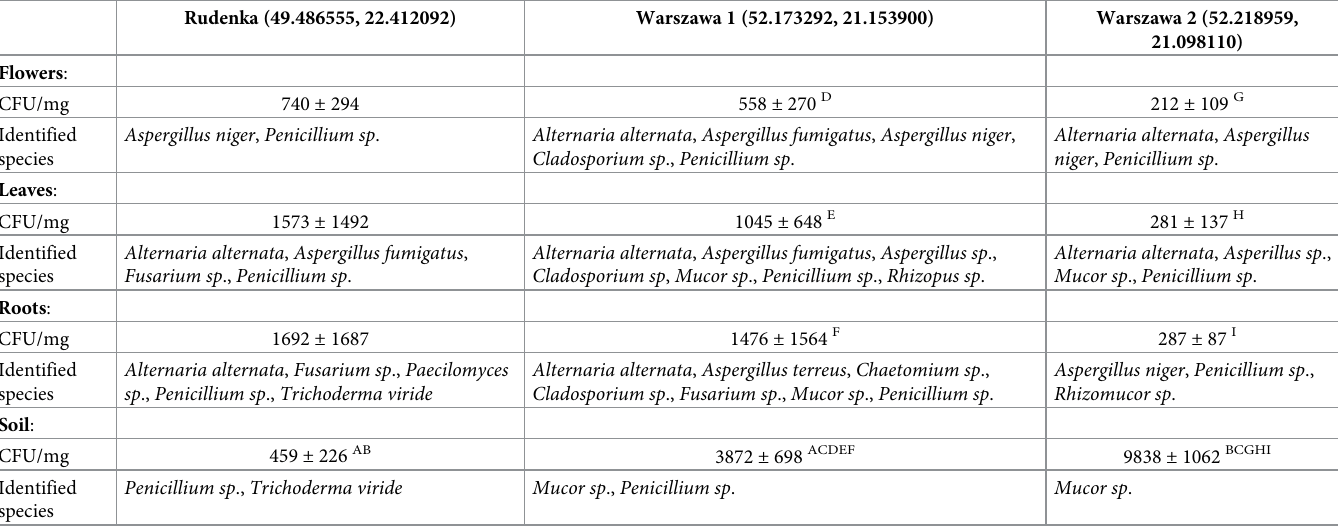
Table 5. Fungi isolated from soil and various parts of Taraxacum officinale plants.